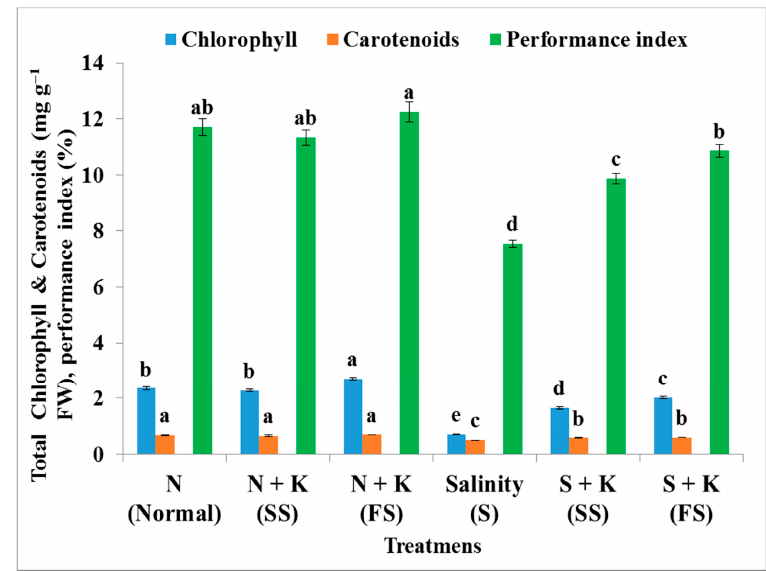
Figure 2. Effect of seed soaking (SS) and foliar spray (FS) of potassium (6 mM K 2 SO 4 ) on photosynthetic pigments and their efficiency (performance index; PI) of soybean plants grown under normal (EC = 2.68 dS m − 1 ) and salt stress (EC = 7.46 dS m − 1 ) conditions. Means followed by the same letter in each parameter are not significantly different according to the LSD test ( p ≤ 0.05). Error bars are ± Standard Error (SE). At 2.68 ds m − 1 salinity, FS with potassium was found to exceed SS and increased K + content and the ratio of K + /Na + while decreasing Na + and Cl − contents compared with the control (Figure 3). Salt treatment significantly reduced K + content and the K + /Na + ratio and significantly increased Na + and Cl − contents compared with the normal control (Figure 3). Compared with the corresponding control, potassium applied as an FS or SS markedly increased the content of K + and the ratio of K + /Na + but significantly decreased the contents of Na + and Cl − under salt stress. FS with potassium was the most effective treatment, increasing the content of K + by 47.18% and the ratio of K + /Na + by 361.29% and reducing Na + by 68.53% and Cl − by 58.82% compared with the control (Figure 3).